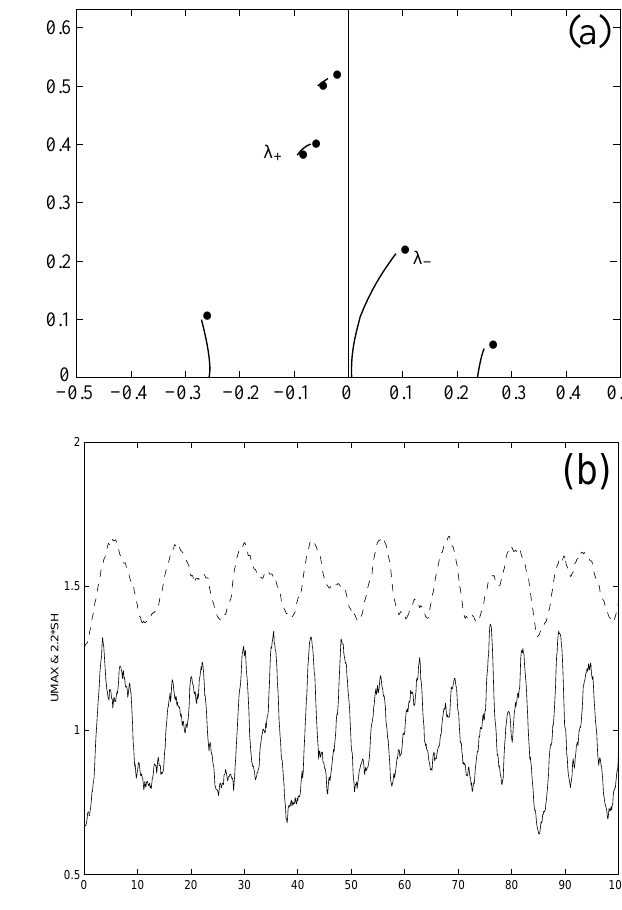
Fig. 17. (a) Spectrum and (b) evolution of U max “far” from “near” to homoclinic data.